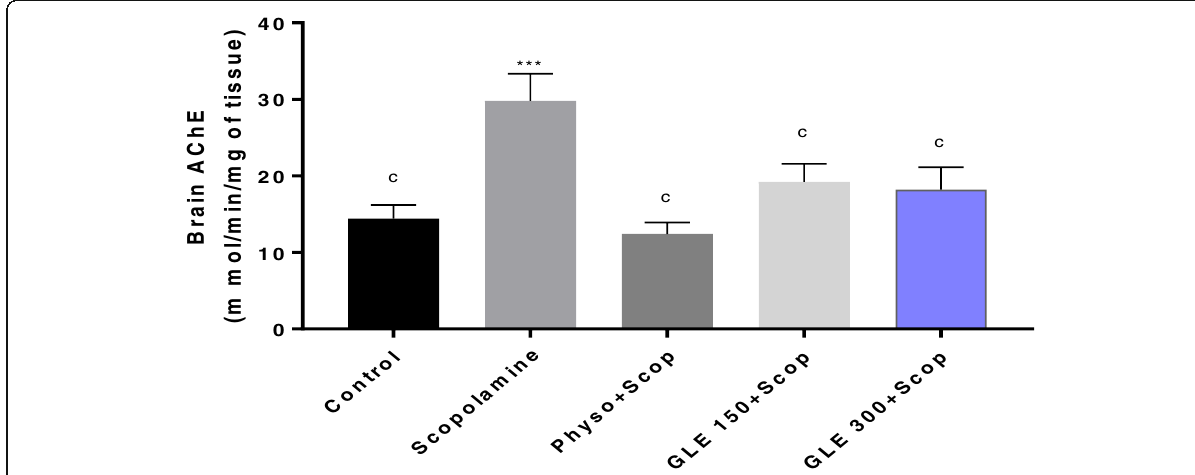
Fig. 3 Effect of Ganoderma lucidum on brain acetylcholinesterase in mice. Animals per group (n)=6; The values are mean±SEM (One-way ANOVA followed by Tukey ’ s Post hoc test). ap<0.05, bp<0.01, cp<0.001 when compared with scopolamine alone treated group. * p <0.05, ** p <0.01, *** p <0.0001 when compared with DW treated (control) group DW, distilled water; GLE 150, Ganoderma lucidum extract (150mg/kg); GLE 300, Ganoderma lucidum extract 300/kg; Scop, Scopolamine; Physo,